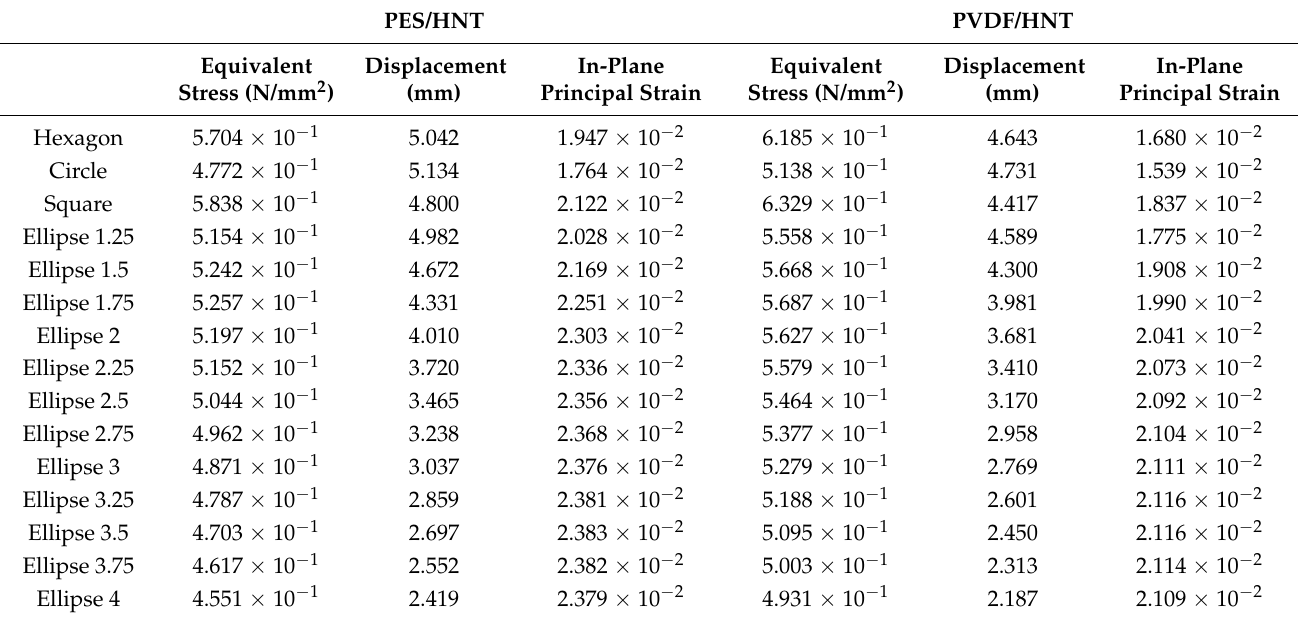
Table 4. Numerical analysis results of PES/HNT and PVDF/HNT membranes in different geometries.